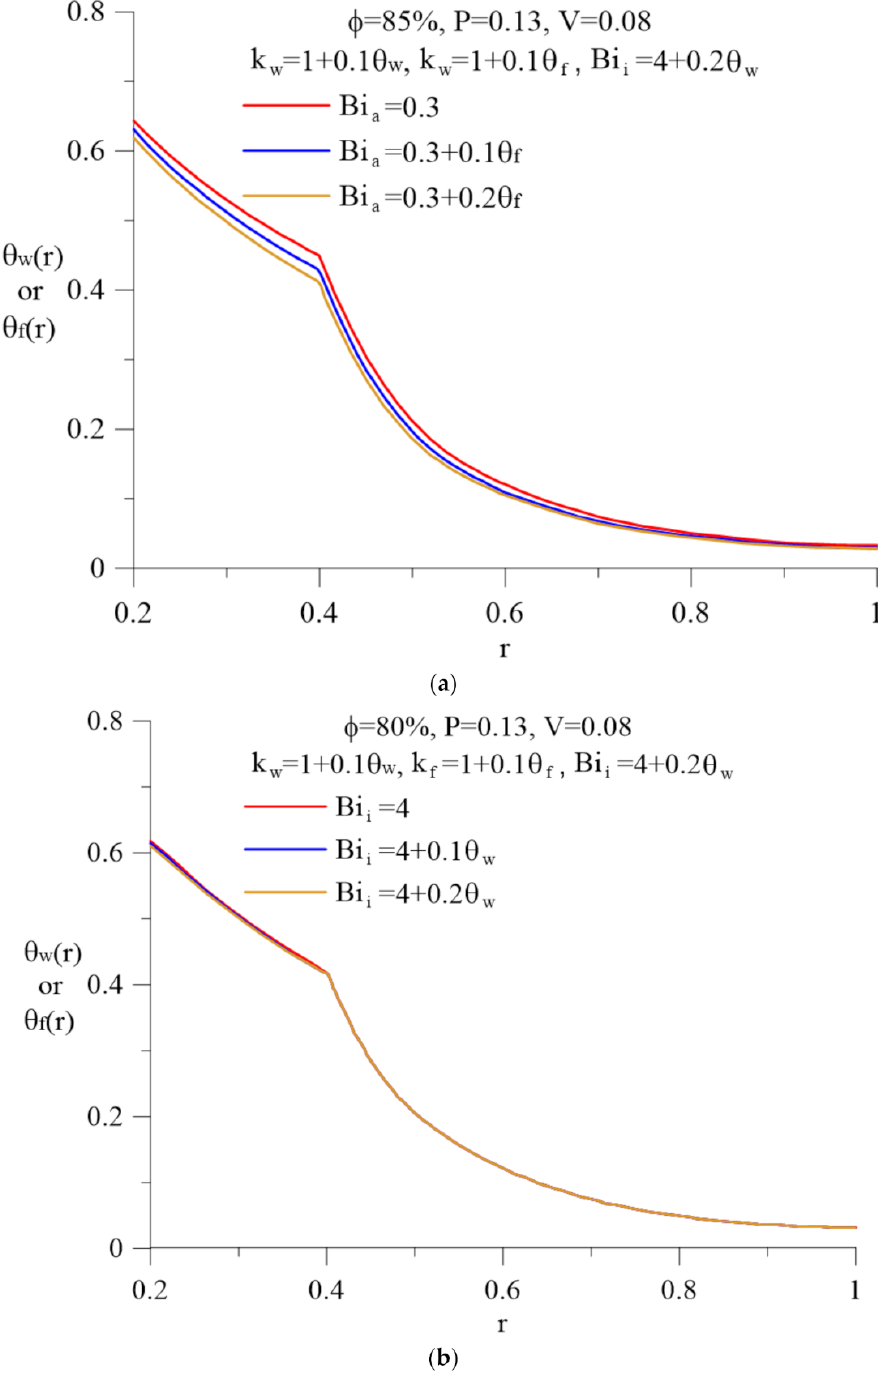
Figure 3. ( a ) The temperature variations of a rectangular fin with various Bi a . ( b ) The temperature variations of a rectangular fin with various Bi i